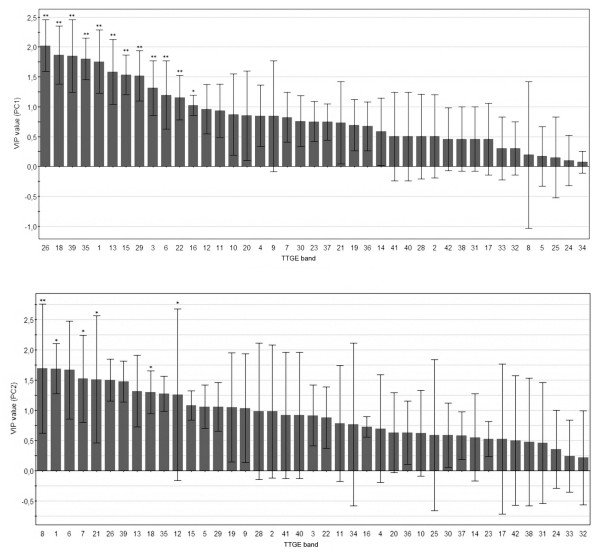
TTGE band importance. Hierarchical variable importance (VIP) of discriminatory TTGE bands for PC1 component (partitioning CD/non CD patients, upper panel) and PC2 component (partitioning active CD/in remission CD patients, lower panel). * P < 0.05, **P < 0.01.